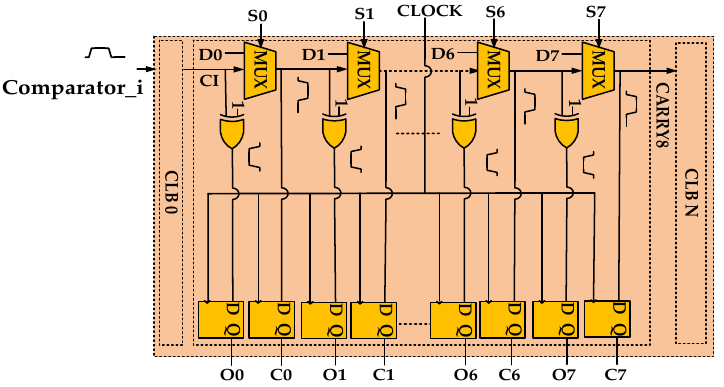
Figure 3. Detailed diagram of the CARRY8 block.